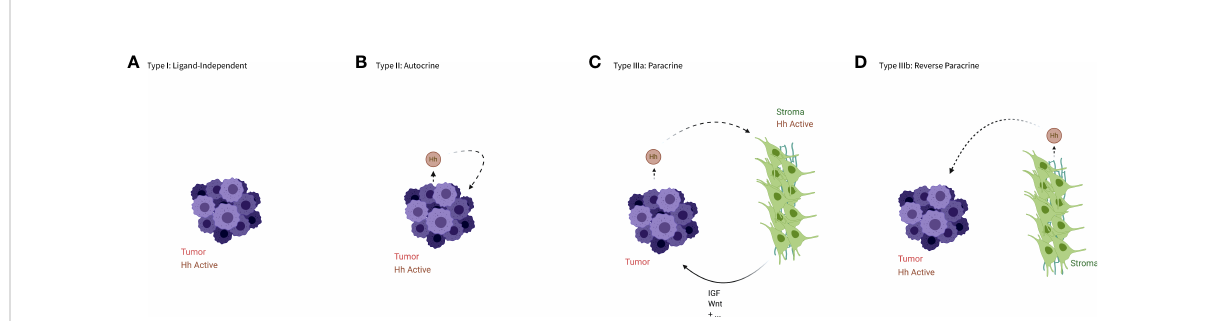
FIGURE 2 An illustration of the types of aberrant HH signaling. (A) In type I signaling, the Hh pathway is active despite the absence of the Hh ligand. (B) In type II or autocrine signaling tumor cells both produce and bind the ligands. (C) In type IIIa or paracrine signaling tumor cells produce ligands that activate HH signaling in the stroma, which in turn produces a more favorable niche for the tumor cells or cancer stem cells. (D) In type IIIb or reverse paracrine signaling the stroma produce ligands to activate HH signaling in the tumor cells. Created in